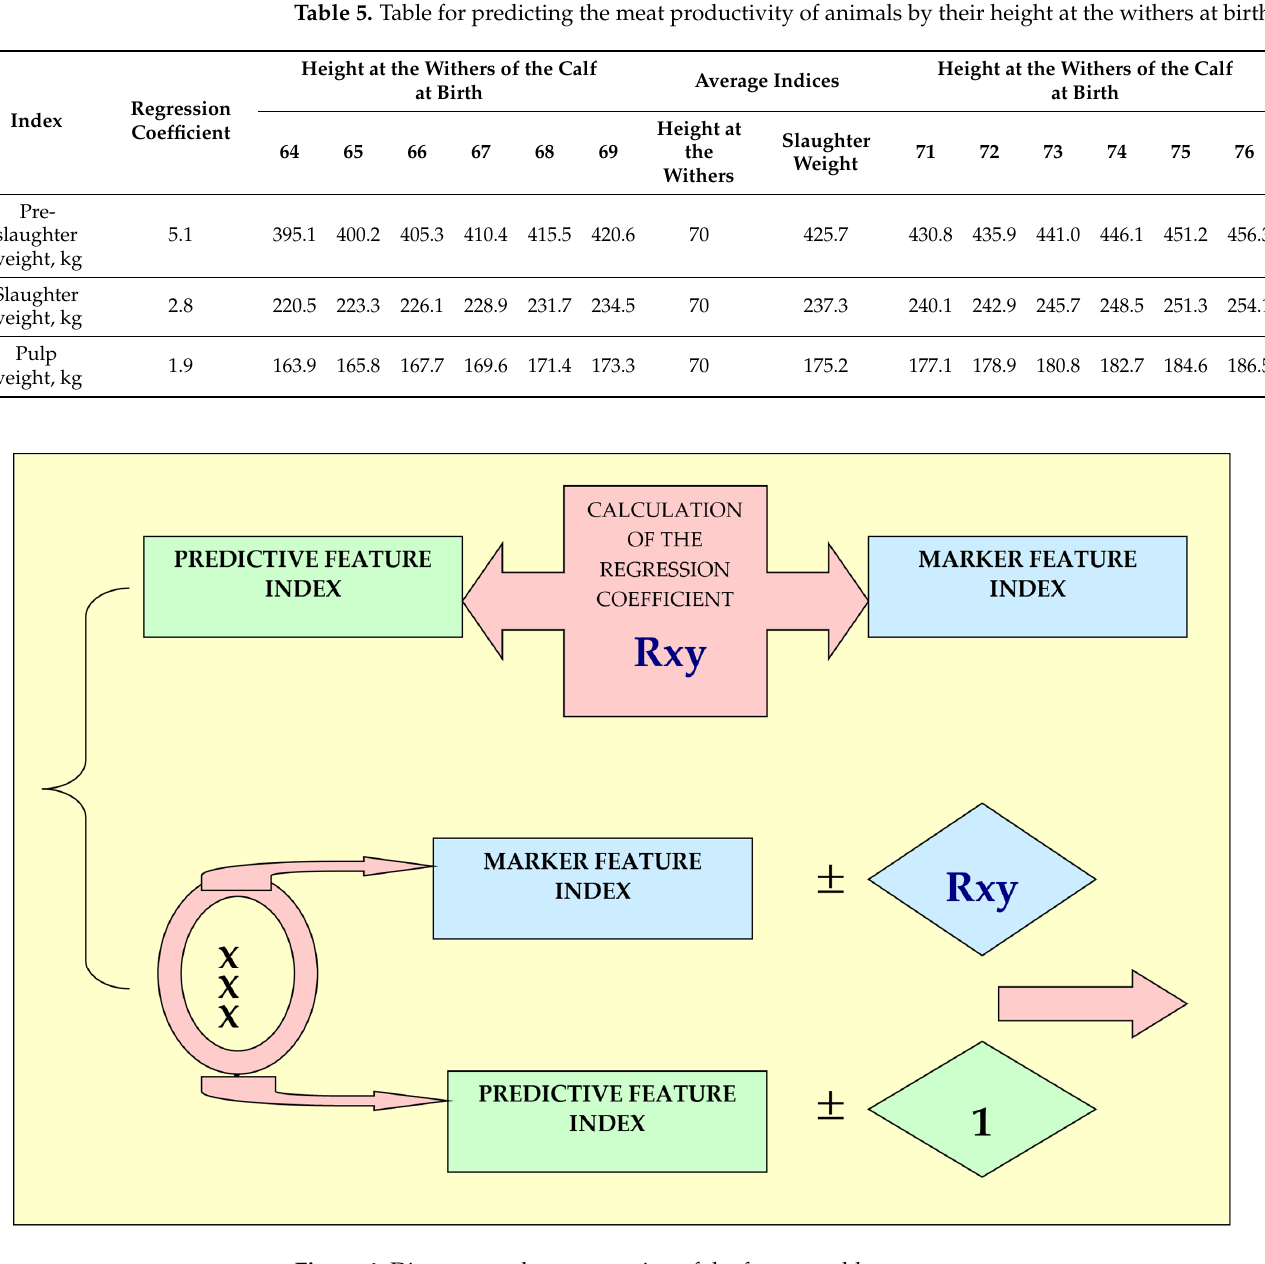
Figure 4. Diagram on the construction of the forecast table.